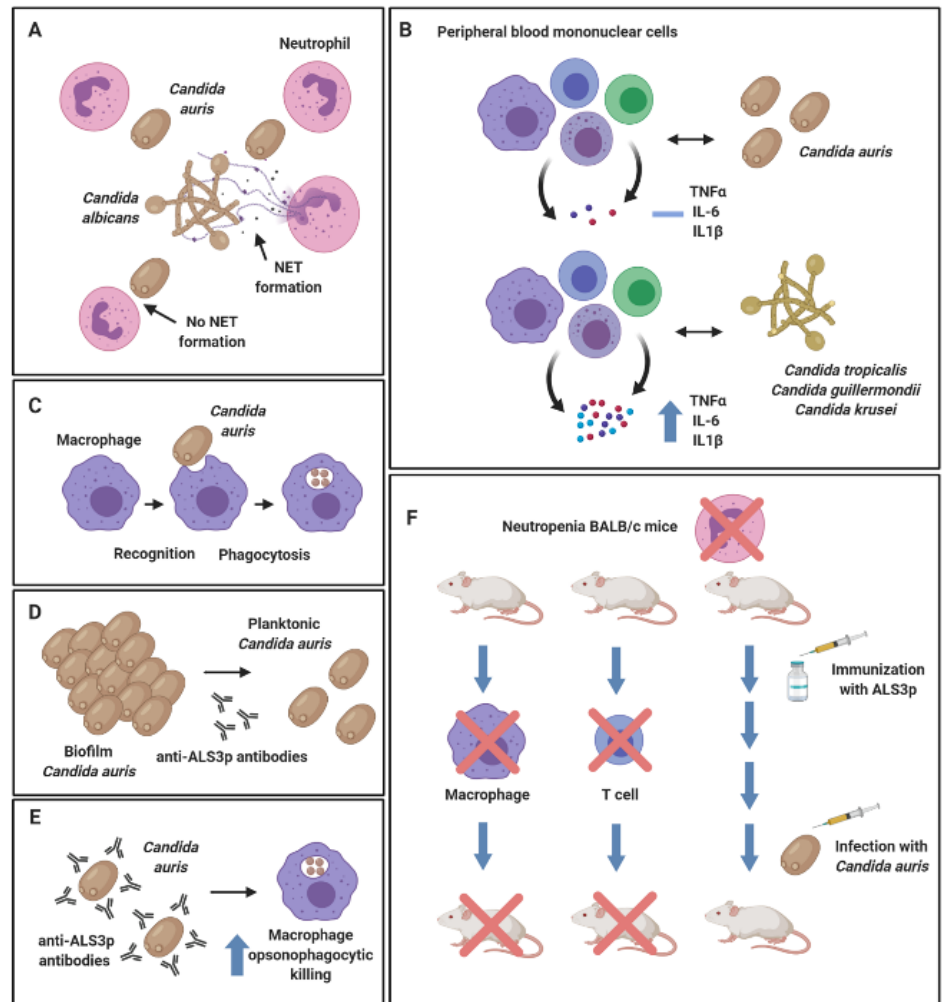
Figure 2. Host-pathogen interactions of Candida